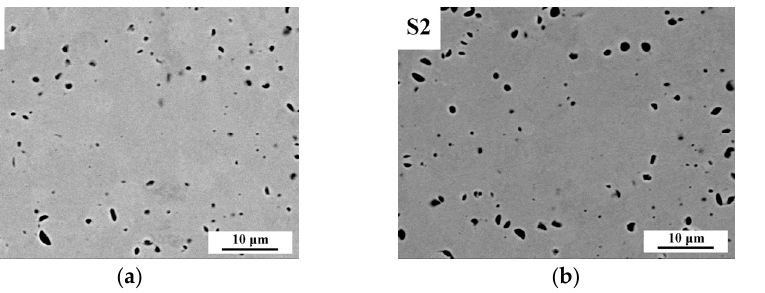
Figure 4. Microstructures of ( a ) 1280-S0, ( b ) 1280-S1, ( c ) 1280-S2 and ( d ) 1280-S3 ODS steels obtained by metallographic microscope.